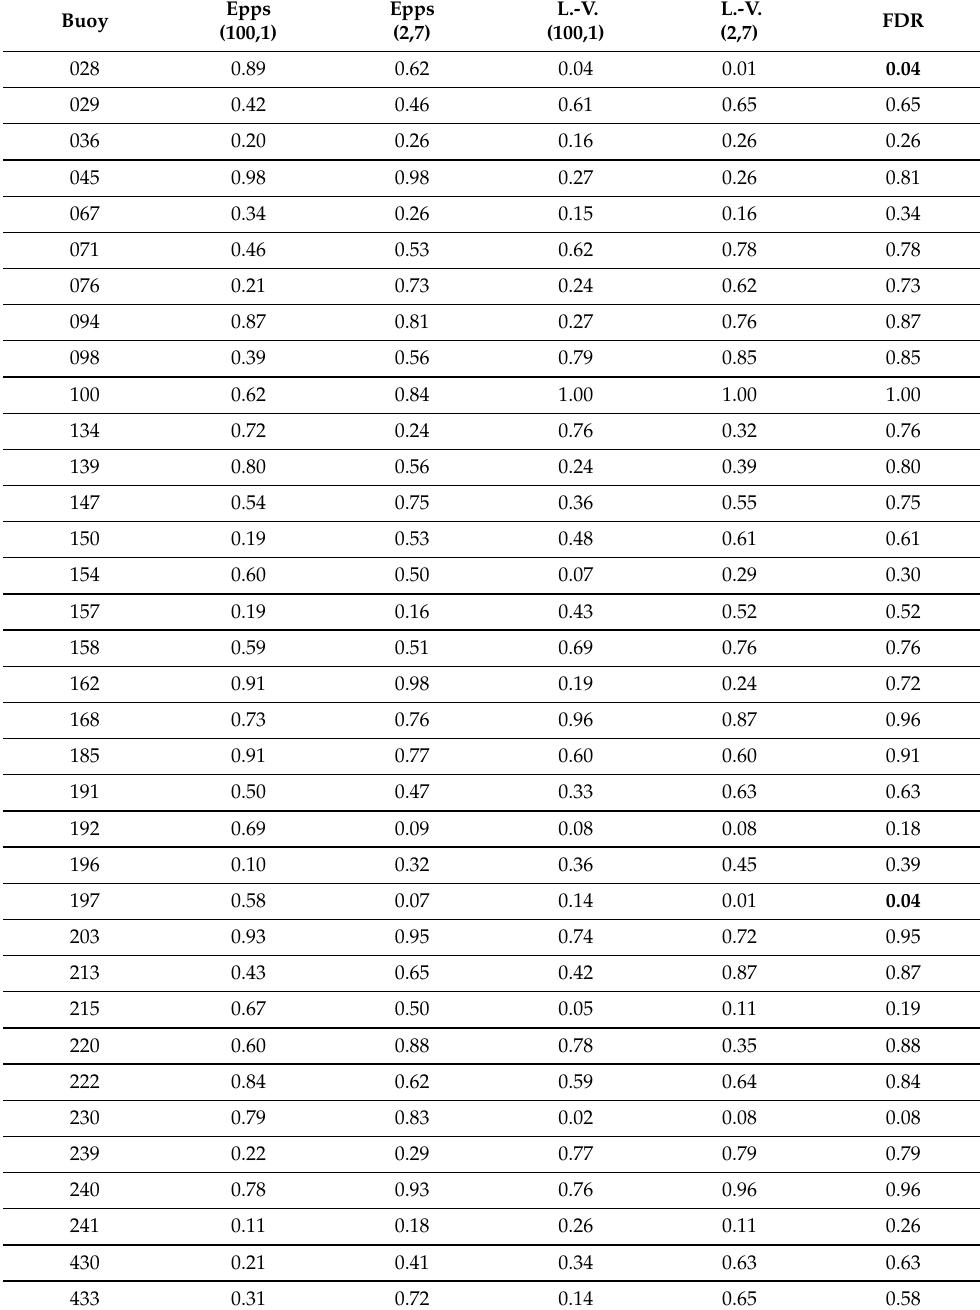
Table 5. FDR values (column 6) resulting of applying the random projection test for each buoy (column 1) with a FDR adjusted p -value larger than 0.05 in Table 4 (time period of 2.13 h in general and of 1.05 h for the buoys in B ). The parameters and the one-dimensional tests used in performing the random projection test are included for each